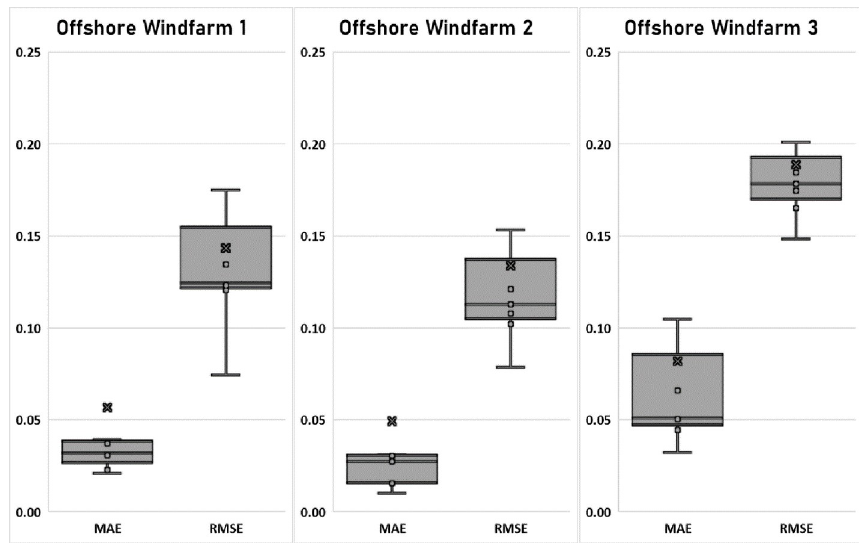
Fig 8. Distribution of forecasting errors (Percentiles) for Offshore Windfarms 1, 2 and 3.